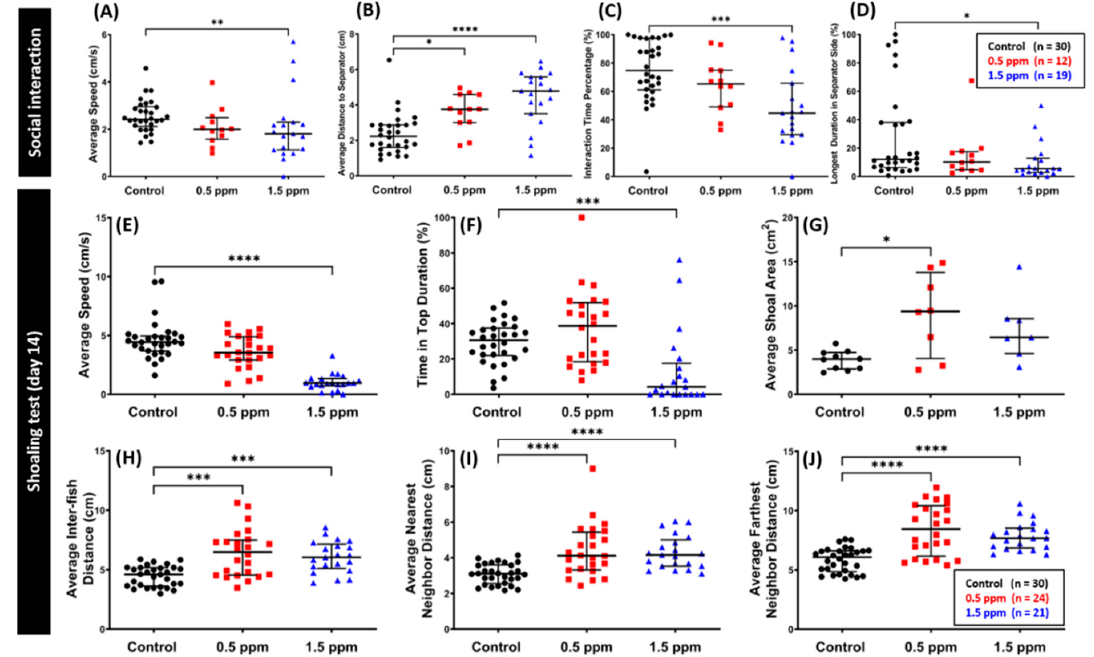
Figure 4. Comparison of social interaction and shoaling behavior endpoints between the untreated control and C 70 NP-exposed fish after 14-day exposure. ( A ) Average speed, ( B ) average distance to separator side, ( C ) interaction time percentage, and ( D ) the longest duration in the separator side were analyzed for the social interaction test ( n = 30 for the untreated control; n = 12 for the 0.5 ppm C 70 NP-exposed fish; n = 19 for the 1.5 ppm C 70 NP-exposed fish). For the shoaling test: ( E ) average speed, ( F ) time in top duration, ( G ) average shoal area, ( H ) average inter-fish distance, ( I ) average nearest neighbor distance, and ( J ) average farthest neighbor distance were analyzed ( n = 30 for the untreated control; n = 24 for the 0.5 ppm C 70 NPs-exposed fish; n = 21 for the 1.5 ppm C 70 NPs-exposed fish, with 3 fish for each shoal). The data are expressed as the median with interquartile range and were analyzed by the Kruskal–Wallis test, with Dunn’s multiple comparisons test as a follow-up test (* p < 0.05, ** p < 0.01, *** p < 0.001, **** p < 0.0001).